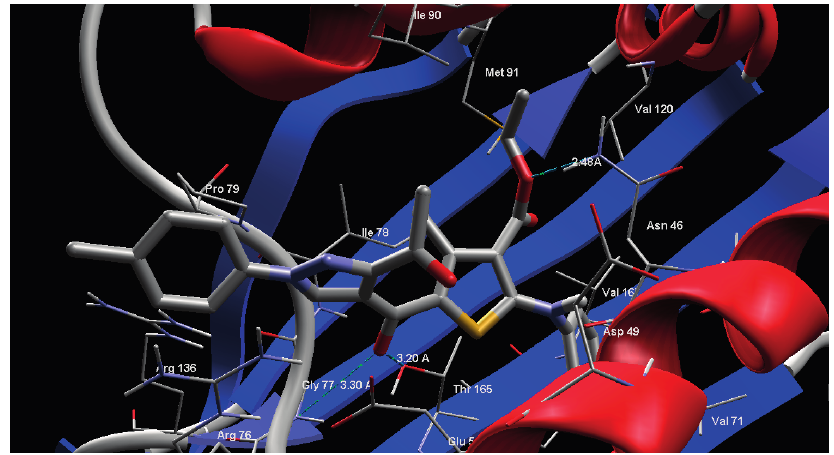
Figure 3. Interaction of compound 9f with the active site of the E. coli 24 kDa domain.